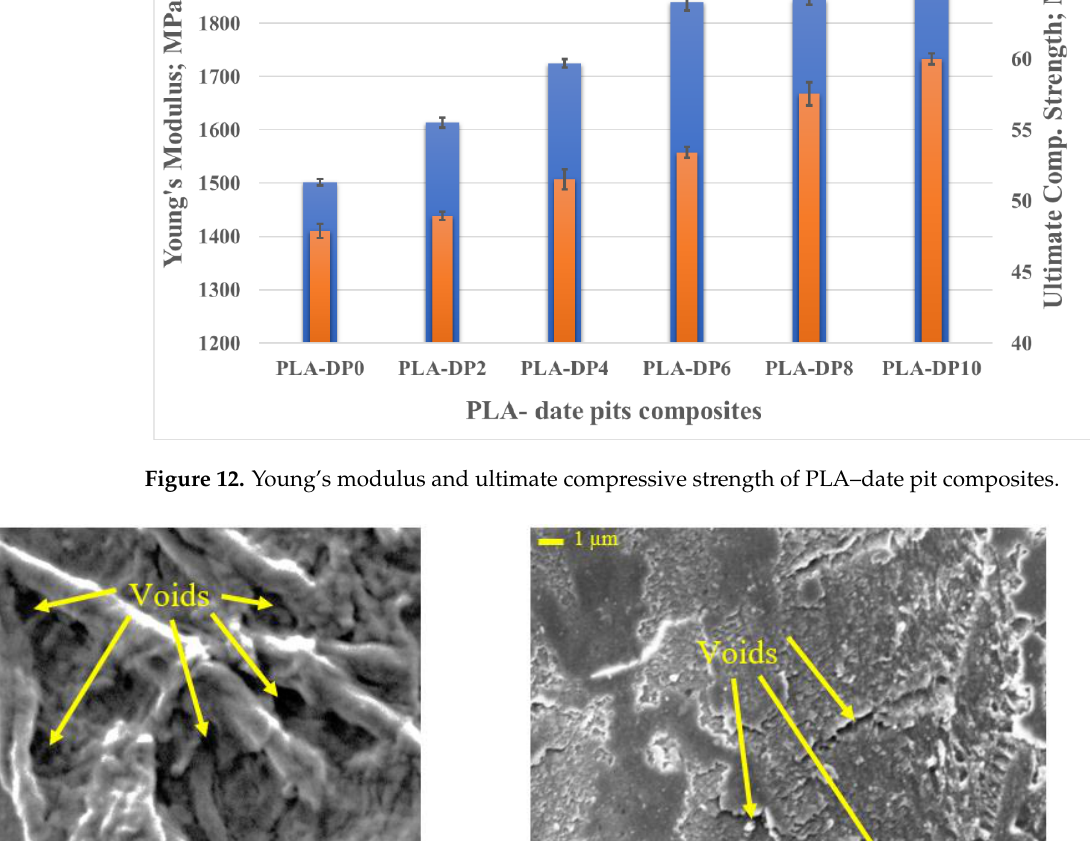
Figure 12. Young’s modulus and ultimate compressive strength of PLA – date pit composites.